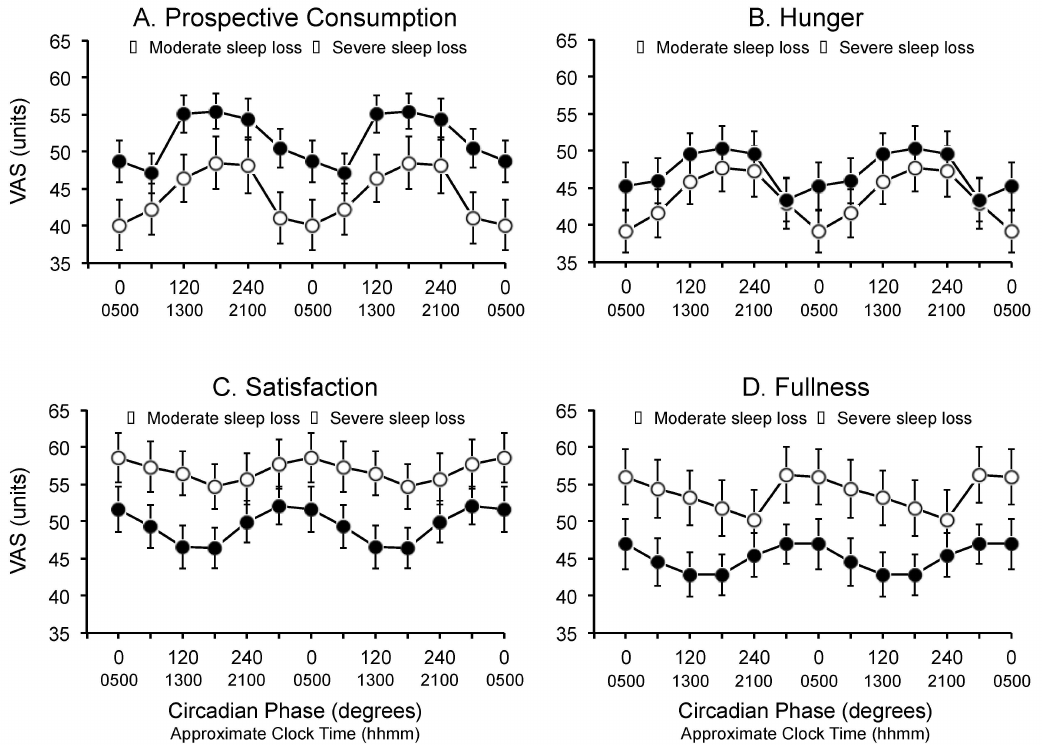
Figure 2. Main effect of circadian phase on ( A ) prospective consumption; ( B ) hunger; ( C ) satisfaction; and ( D ) fullness during the forced desynchrony segment of the protocol for participants in the moderate sleep restriction condition (open circles) and the severe sleep restriction condition (closed circles). Data are double-plotted relative to the circadian nadir (degrees) and are plotted at the midpoint of the bins. Data are mean ˘